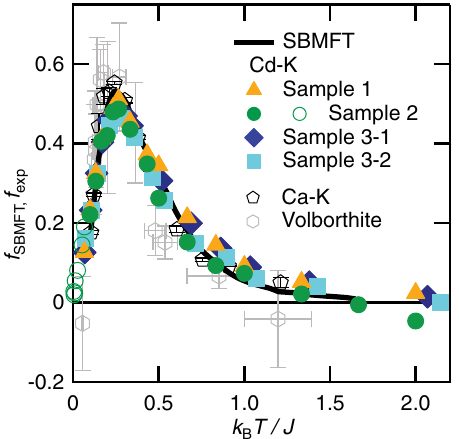
FIG. 10. Normalized thermal Hall conductivity f lattice antiferromagnets fitted by the parameters listed in Table I. The solid line shows a numerical calculation of f 0 . 1 by the SBMFT [26]. The data of Ca-K and those of volborthite are taken from Refs. [26,25],